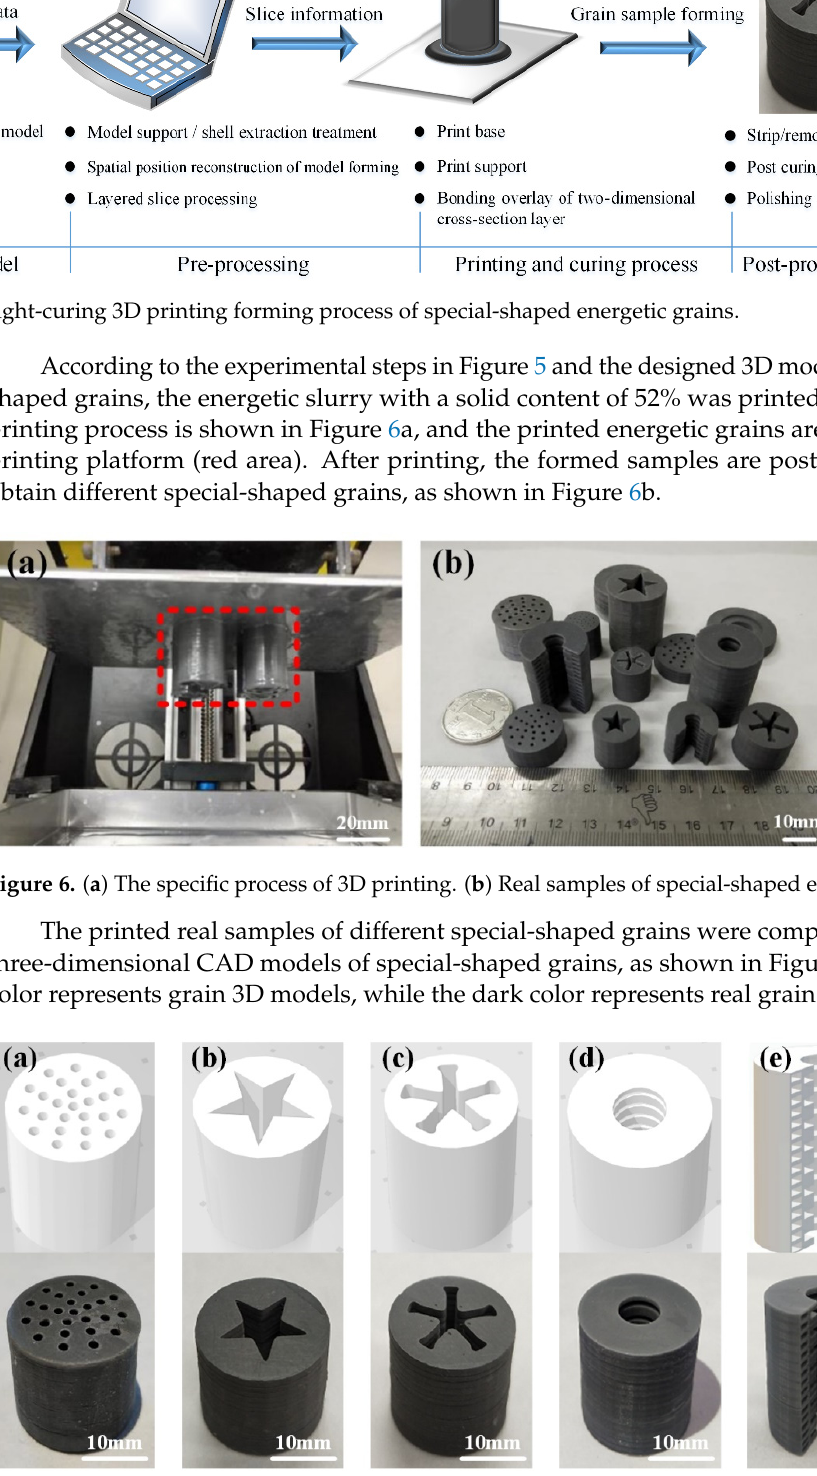
Figure 7. Three-dimensional CAD models of special-shaped grains and printed real samples of special-shaped grains: ( a ) Porous shape; ( b ) Star shape; ( c ) Wheel shape; ( d ) Multi-row annular hollow groove tube shape; ( e ) Cross-section of multi-row annular hollow groove tube shape. It can be seen from Figure 7 that the real samples of energetic grain printed by the light-curing 3D printing technology highly and truly restored the characteristics of the 3D models of the grains with high printing accuracy and fast forming speed.